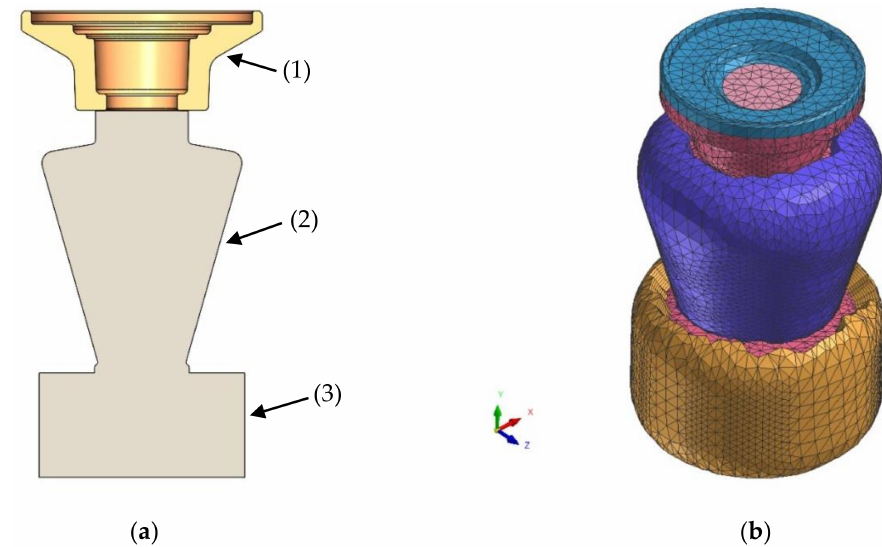
Figure 2. Design of the casting assembly. ( a ) Cross section view in SolidWorks ® and ( b ) model mesh distribution in ProCAST ® software. (1) Pouring cup, (2) gating system, and (3) part.